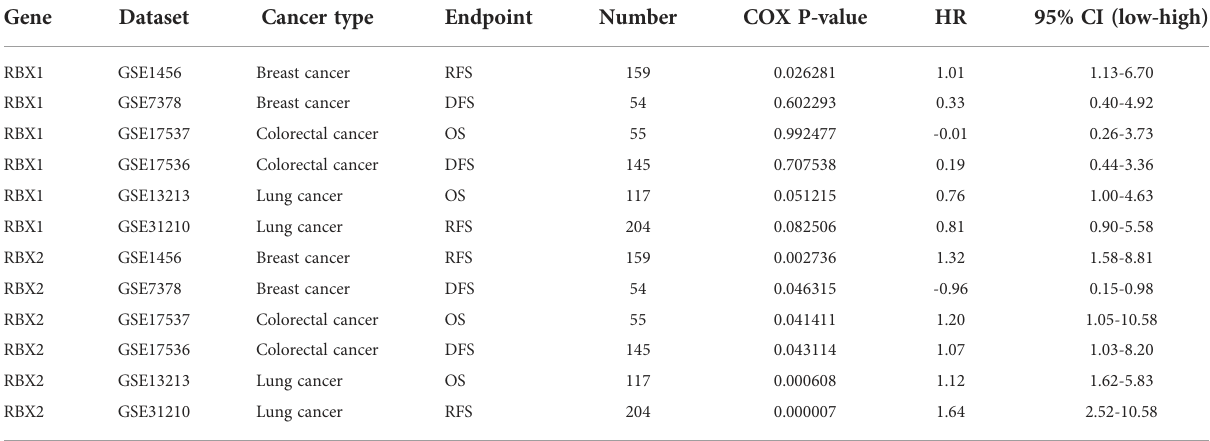
TABLE 1 Ring fi nger family gene expression was related to the prognosis of different cancers in PrognoScan.